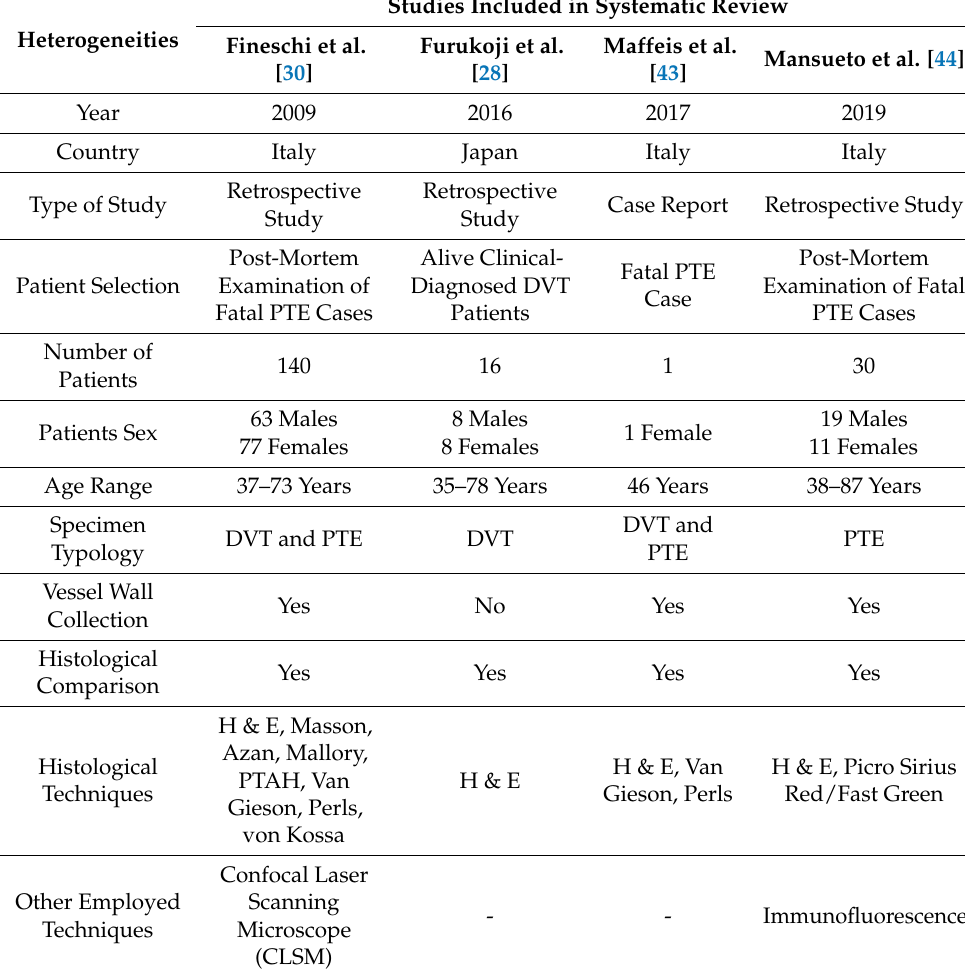
Table 2. Bias assessment between selected